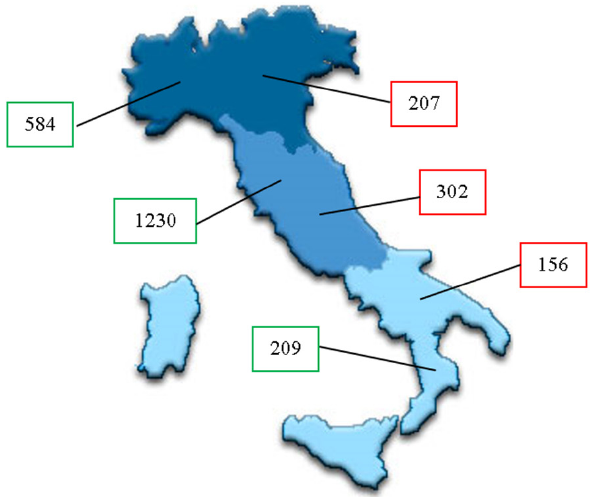
Figure 2. Distribution of PCPs (numbers showed on the right) and families (on the left) interviewed across Italian regions (North, Center and South).